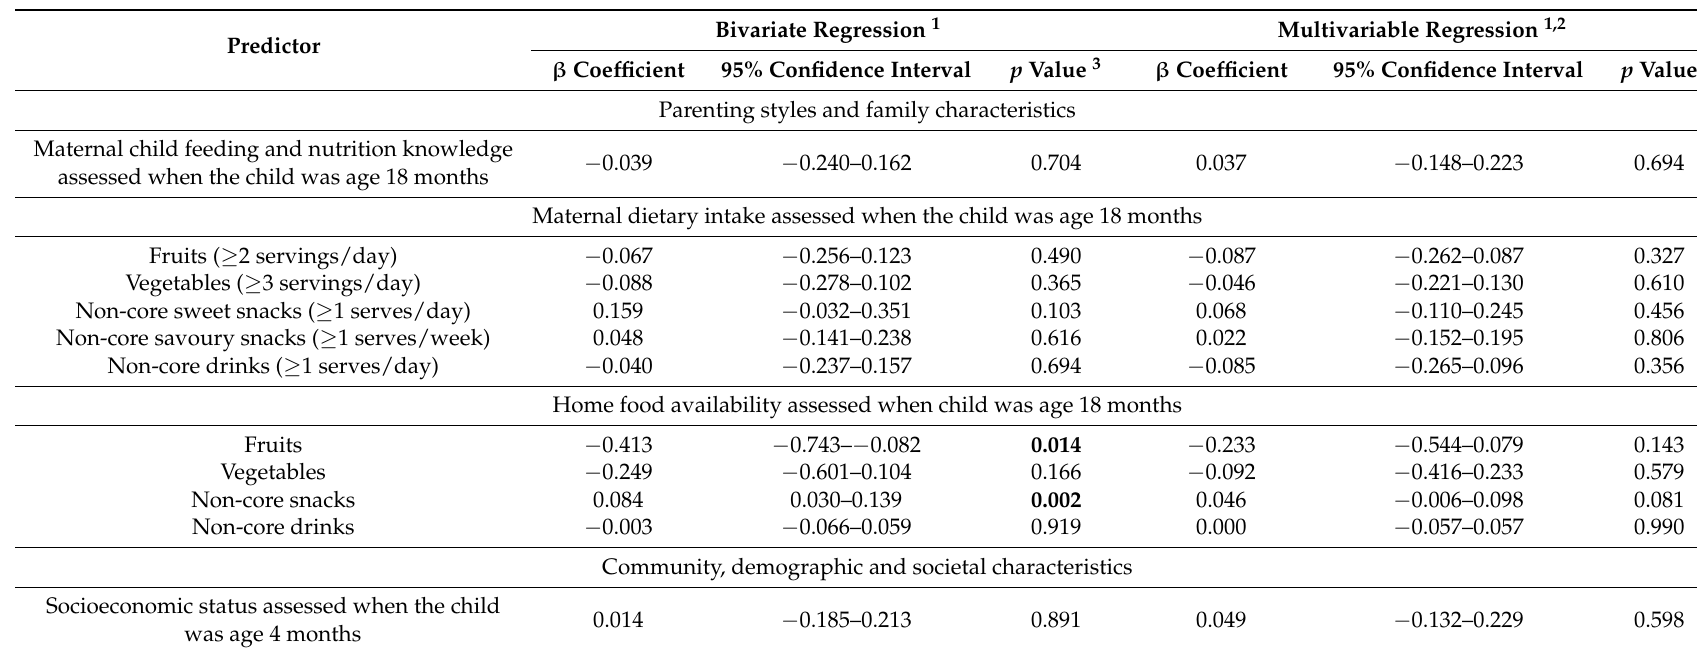
Table 5. Results of bivariate and multivariable linear regression analyses among children participating in the Melbourne InFANT Program ( n = 209) for the predictors and the dietary energy density variable dietary energy density from food and all beverages (DED food+all beverages